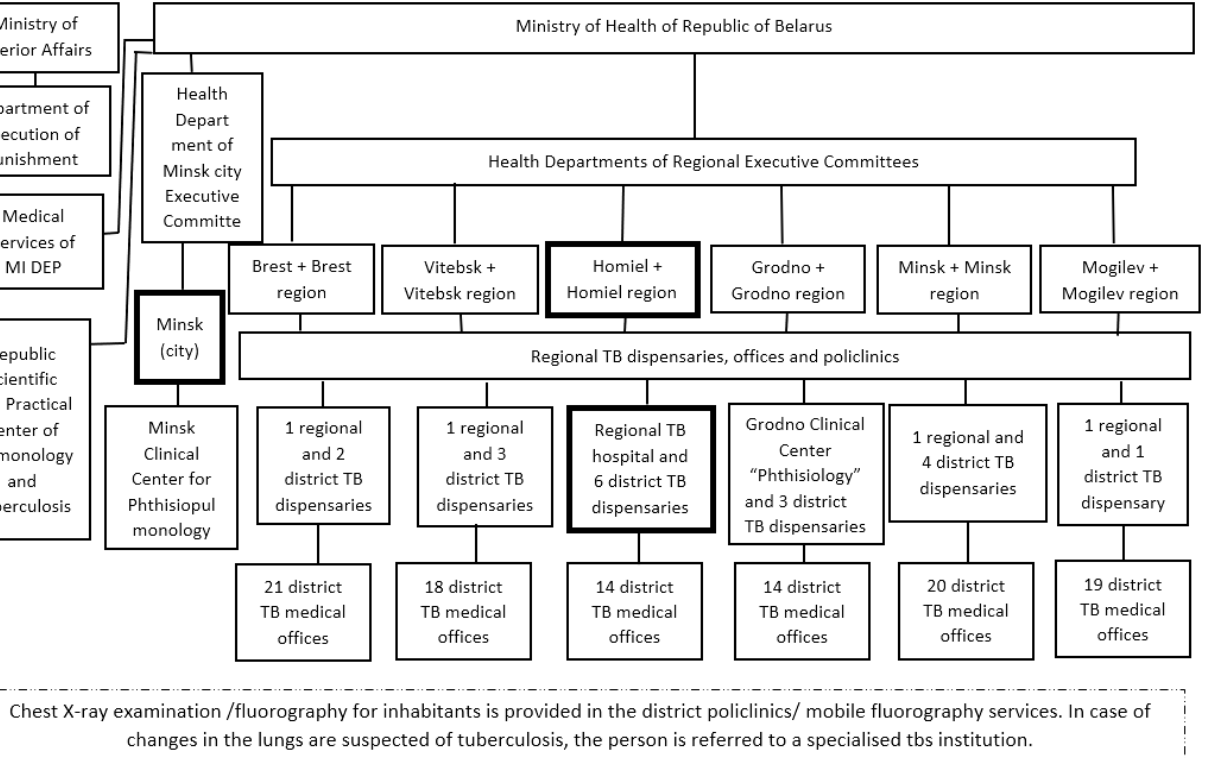
Figure 1. The structure of tuberculosis service in the Republic of Belarus. Footnote: The vertical structure of TB services (TB dispensaries) in each country region is divided by districts. (Boxes with bold boundaries indicate the districts and city (Minsk) where data were collected for the project).